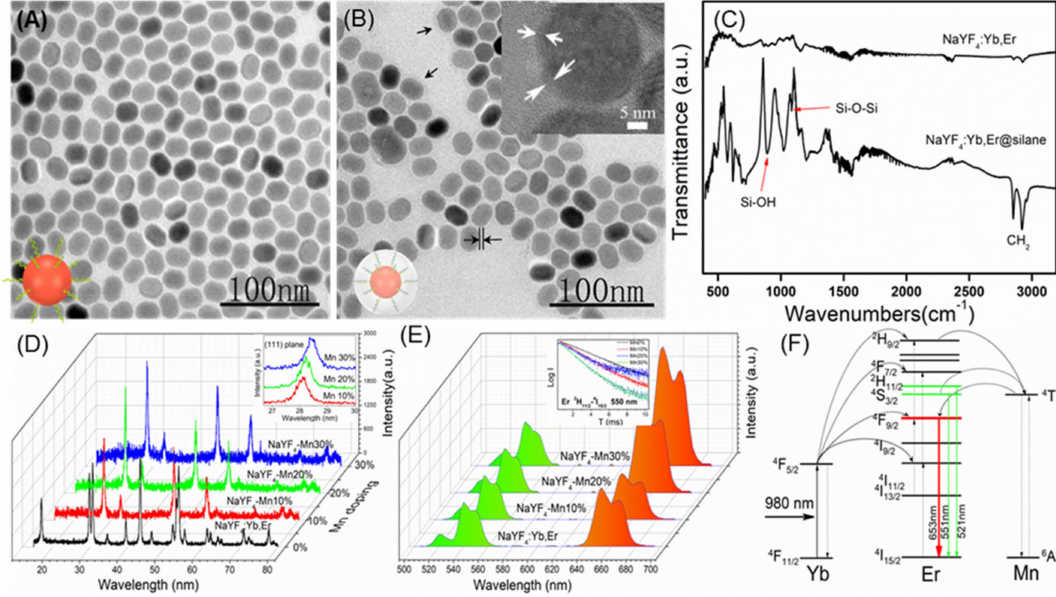
Figure 2. Characterization of the NaYF 4 :Yb 3 + ,Er 3 + ,Mn 2 + (0%, 10%, 20%, 30%)UCNPs. ( A ) and ( B ) are the TEM images of NaYF 4 :Yb 3 + ,Er 3 + and silane modified NaYF 4 :Yb 3 + ,Er 3 + UCNPs, respectively. Color insets in ( A , B ) showed the schematic structures of nanoparticles. HR-TEM insets in B showed the high magnification of single nanoparticles. ( C ) FT-IR spectra of NaYF 4 :Yb 3 + ,Er 3 + and silane modified NaYF 4 :Yb 3 + ,Er 3 + UCNPs. ( D ) XRD pattern of NaYF 4 :Yb 3 + ,Er 3 + ,Mn 2 + (0%, 10%, 20%, 30%) UCNPs. The inset is the amplified di ff raction peak of 111 plane of the NaYF 4 :Yb 3 + ,Er 3 + ,Mn 2 + (10%, 20%, 30%) UCNPs. ( E ) Upconversion fluorescence spectra of NaYF 4 :Yb 3 + ,Er 3 + ,Mn 2 + (0%, 10%, 20%, 30%) UCNPs with 980 nm excitation. The inset is the lifetime of the 2 H 11 / 2 energy level corresponding to green emission. ( F ) Proposed energy transfer mechanisms under the excitation of 980 nm